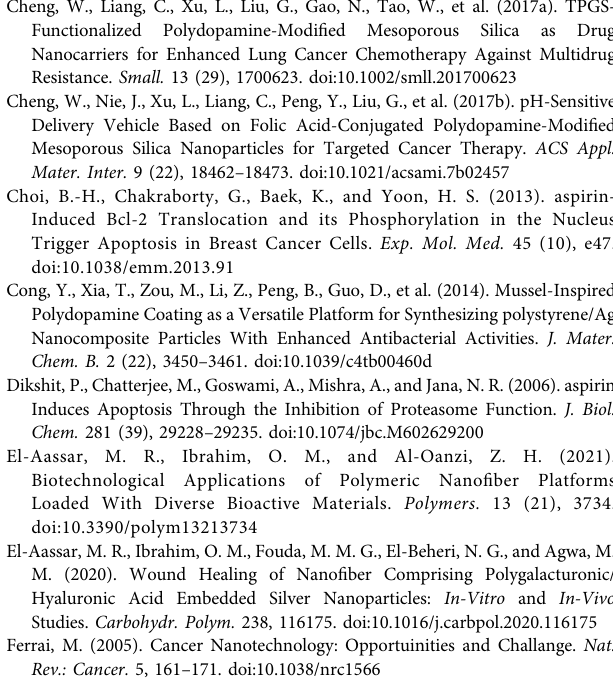
Supplementary Figure 1 | MTT assay-based cell viability of human kidney (HK) cells examined at 48 h; cell culture is treated with negative control (NT), free drug (aspirin), drug loaded in MSNs (MSNs aspirin), and all other derivatives of aspirin loadedMSNspreparedinthisstudy(MNP-Asp@PD,MNP-Asp@PD-PG,andMNP-